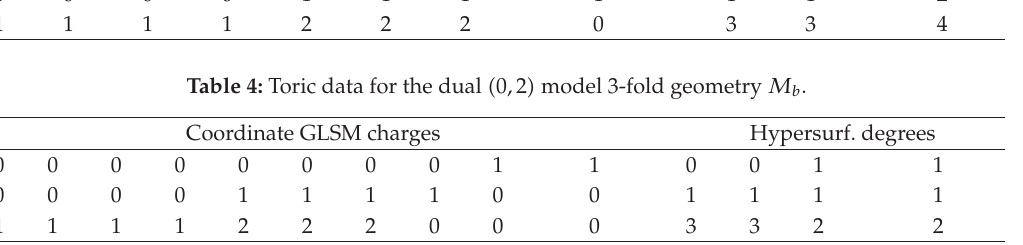
Table 3: Toric data for the smooth (cid:2) 2 , 2 (cid:3) model 3-fold geometry M Coordinate GLSM charges Hypers. degrees